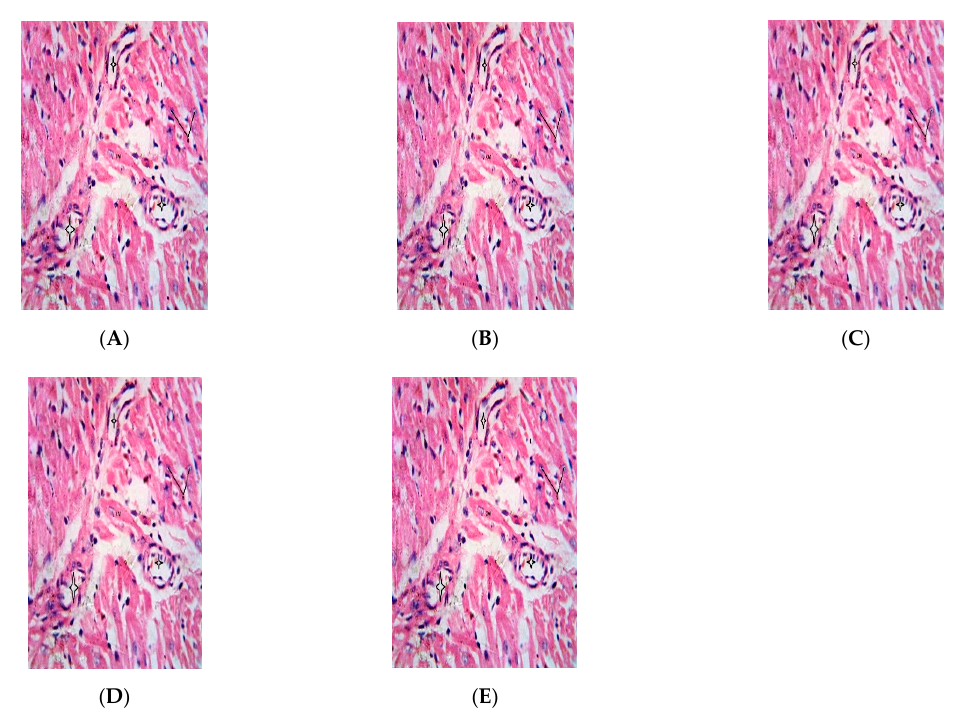
Figure 6: Photomicrograph of kidney section of Wistar rats repeatedly dosed with ( A ) 62.5 mg/kg bw, ( B ) 125 mg/kg bw, ( C ) 250 mg/kg bw of P. dactylifera essential oil and ( E ) control showing intact glomerulus (G), other renal features appear normal and unremarkable (×400 H and E Staining); ( D ) 500 mg/kg bw of P. dactylifera essential oil showing mild congestion (CG).